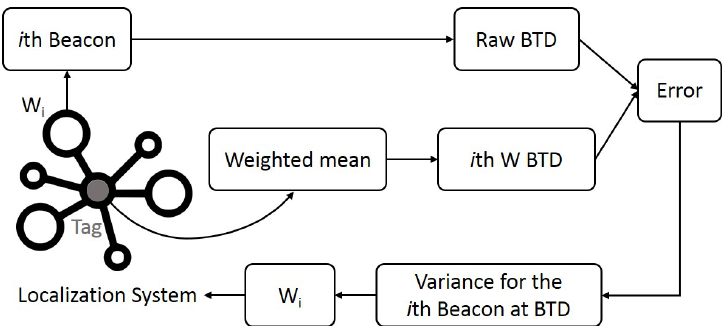
Figure 2. Schematic representation of the proposed trilateration algorithm. The logic represents the processing loop for the i th beacon at a new frame acquired by the